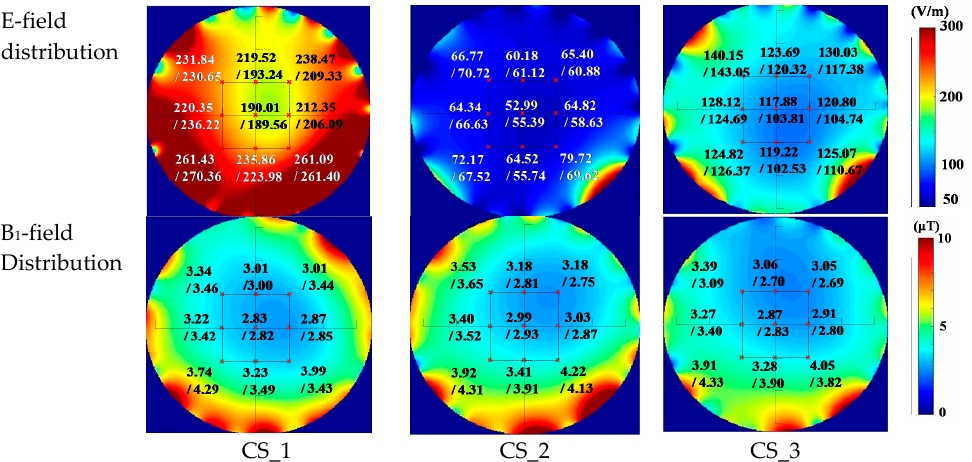
Figure 5. The simulated and the measured RMS field values on the three selected slices. The values were presented by “simulated result/ measured result”. The measured points were indicated by red x. The power to the coil was 6 kW (in measurement) and 3.5 kW (in simulation). The incident power was not identical for the simulation and measurement due to the inaccuracy in modelling. The discrepancy could be adjusted and compensated in simulations. In fact, the similarity of field distribution was a much more important factor. The mean deviation of the amplitude on these points was 6.13%, with a standard deviation of 3.92%. The maximum deviation was 14.42%.